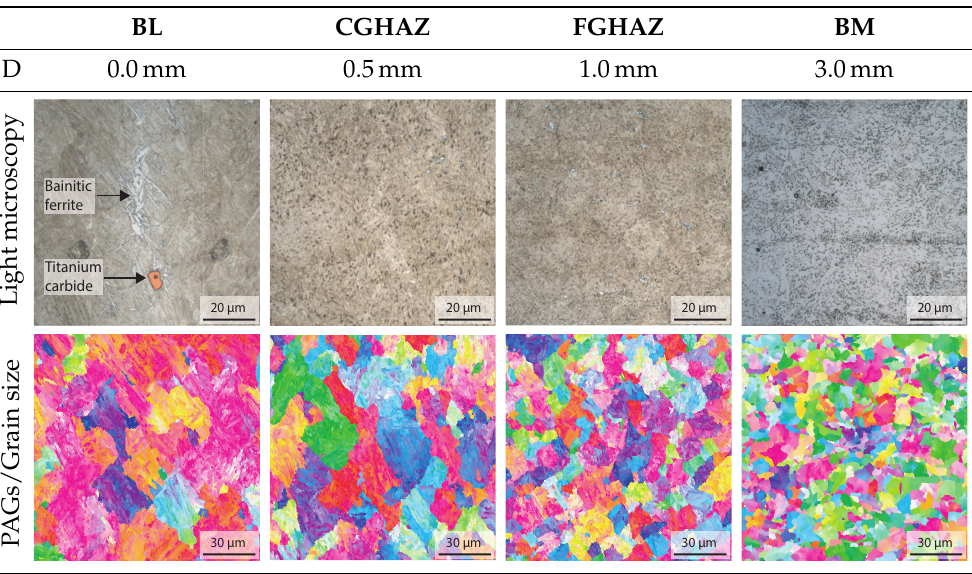
Table 2. Light optical microscopy images and prior austenite grain size (PAGs) of the bonding line (BL), coarse and fine grained heat affected zone (CGHAZ, FGHAZ) and the base material (BM) of the weld seam in the as-welded state at different distances (D) from the bonding